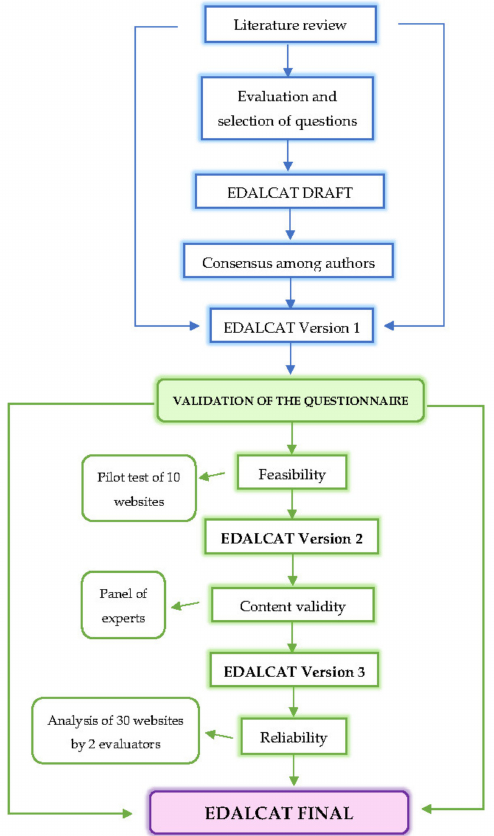
Figure 1. Design and validation phases of the EDALCAT